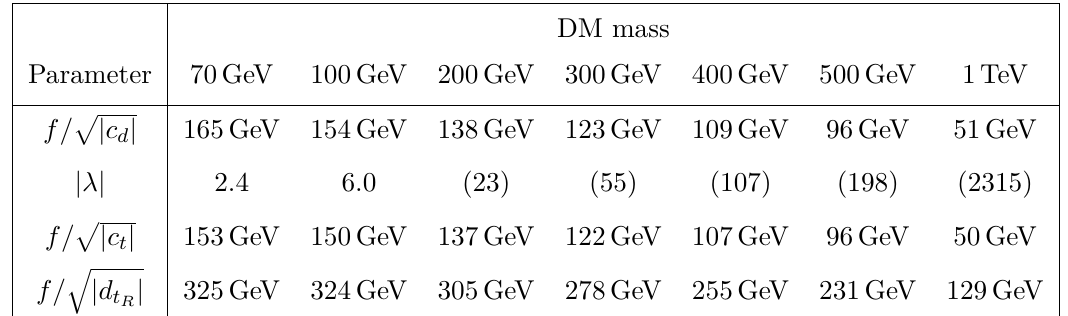
search strategy described in section 4.1 T